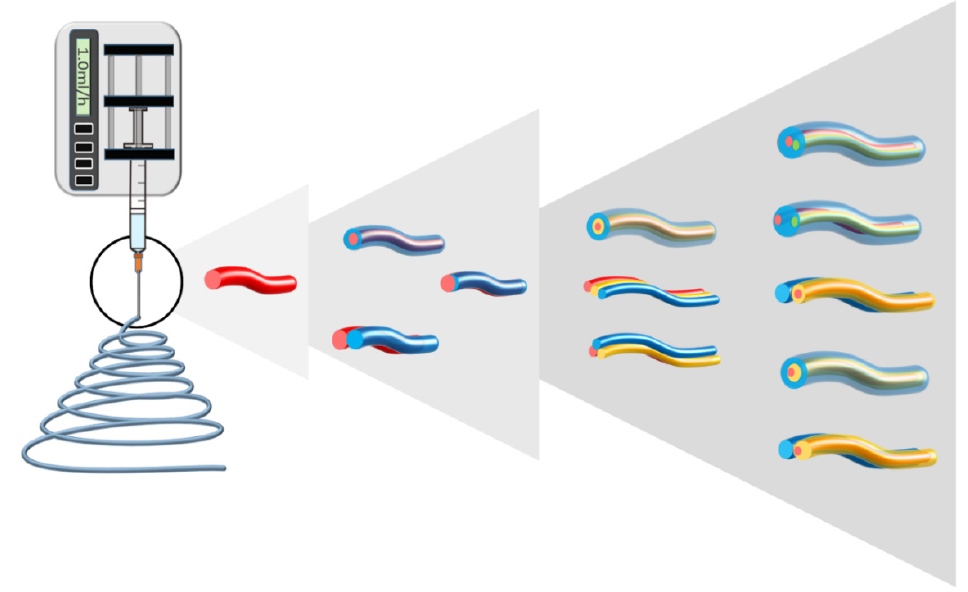
Figure 6. Structural development of high-voltage electrospinning.